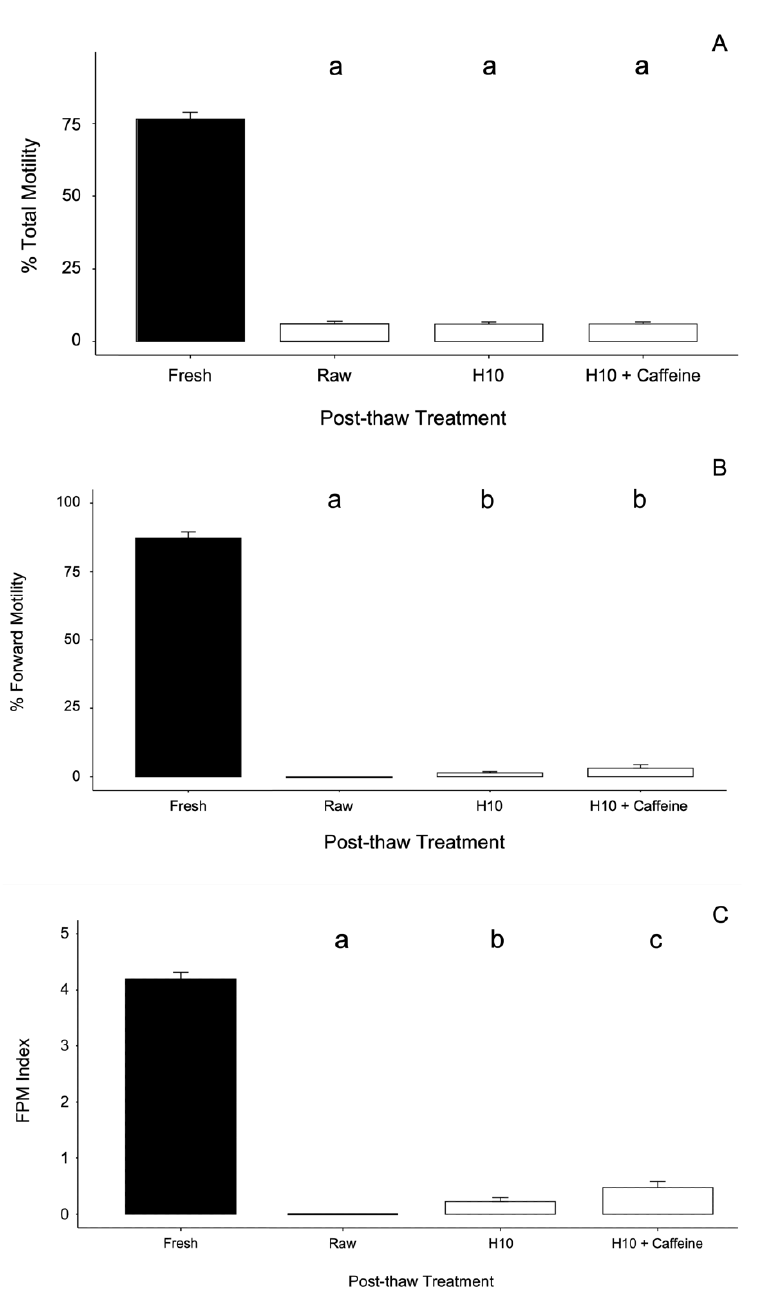
Figure 2. Barplot of ( A ) percent total motility, ( B ) percent forward motility, ( C ) FPM index of thawed sperm of the Louisiana pinesnake: not diluted (Raw), diluted in H10 (H10), or diluted in H10 with 10 mM caffeine (H10 + Caffeine). Bars represent the means and standard deviation for each experimental group. Kruskal–Wallis tests for significance followed by Dunn’s post-hoc test with the Benjamini–Hochberg correction for multiple comparisons to compare CPA treatments; alpha was set at 0.05. The letters represent significantly different groups, and the black filled bars represent fresh samples and were not included in the statistical tests.